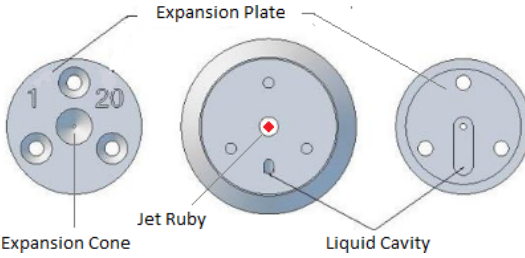
Figure 1. Components of the BLAM nozzle body. Extracted and modified from the BLAM user’s